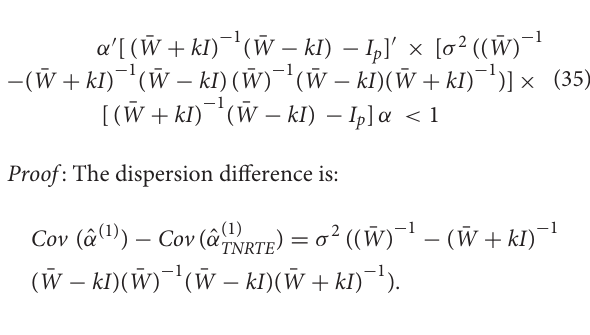
TABLE 4 | Simulation results in case of p